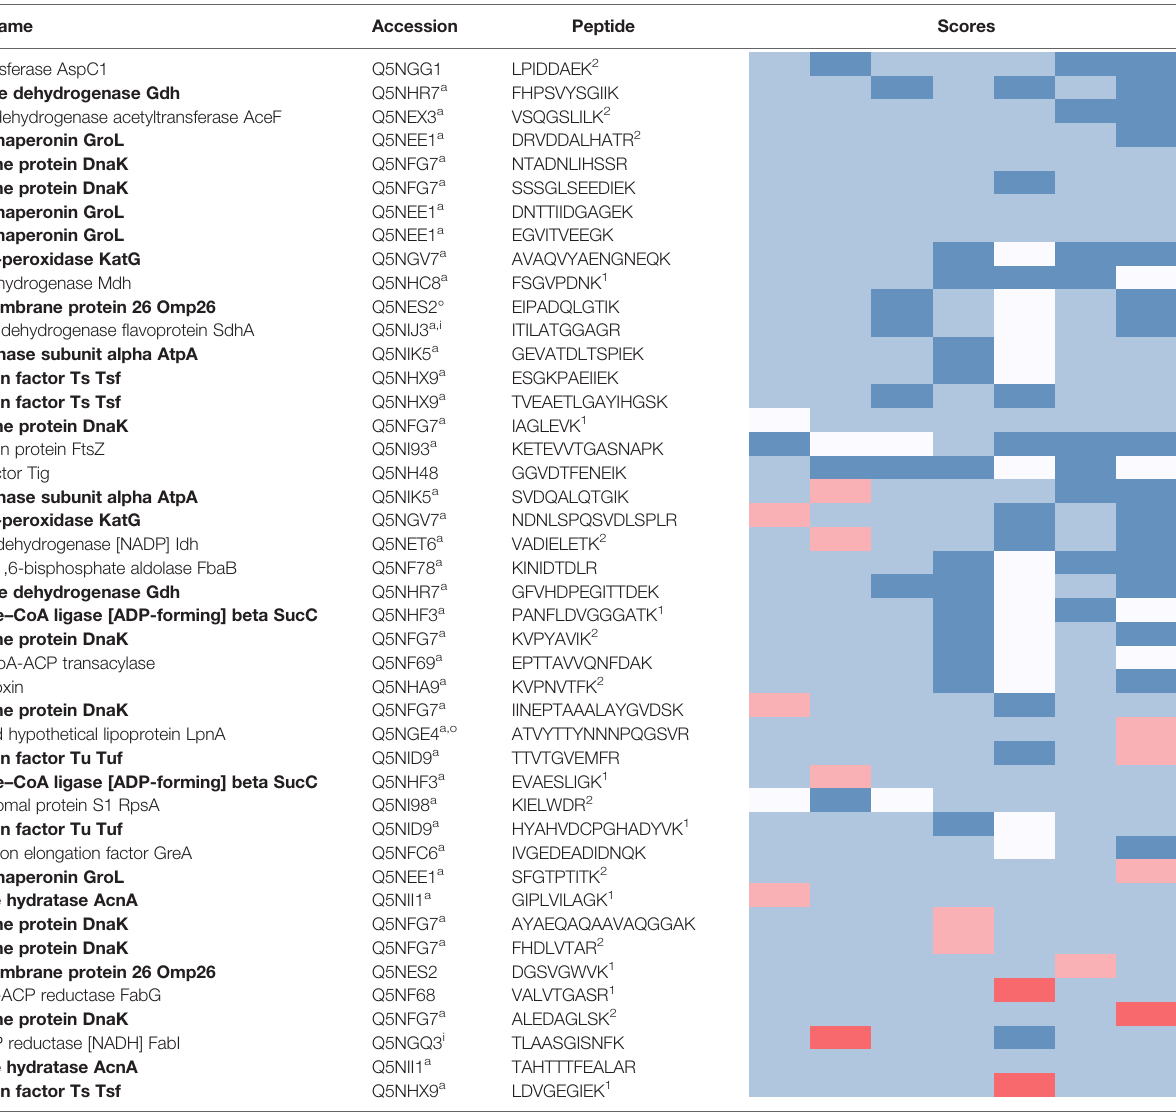
TABLE 1 | List of top scoring immunoreactive peptides identi fi ed for Francisella tularensis